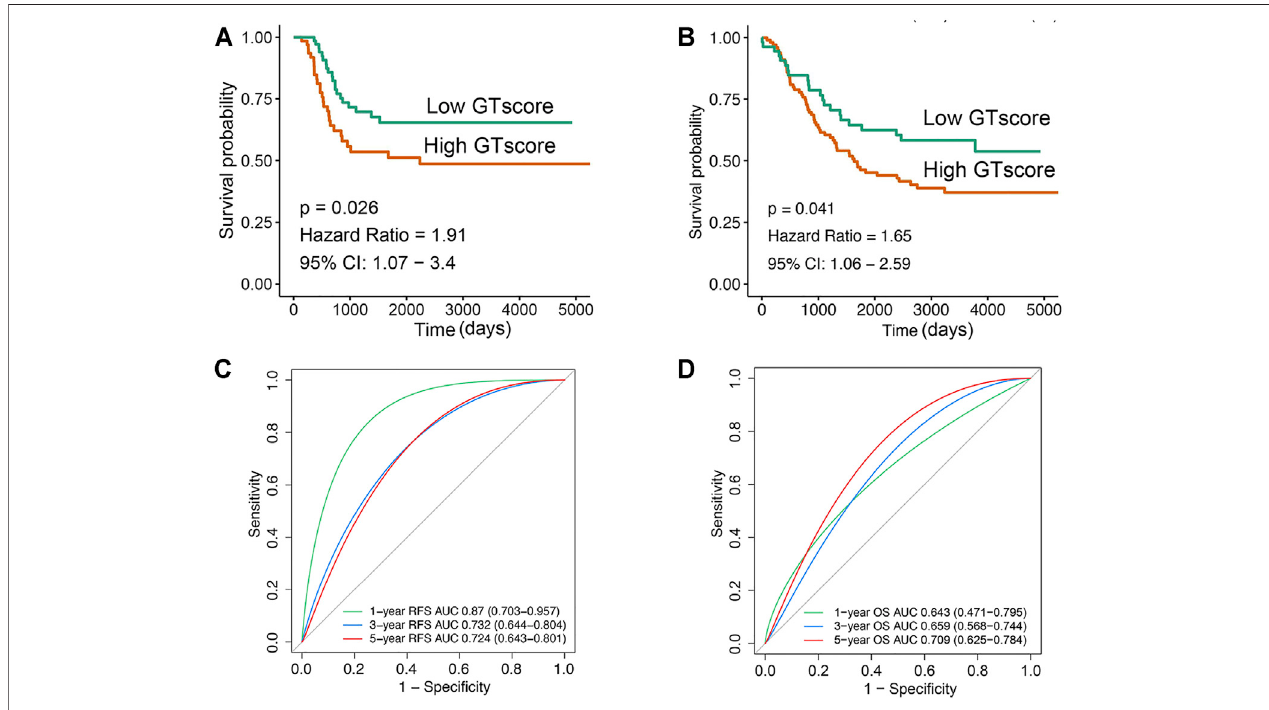
FIGURE 5 | Validation of the prognostic value of GTscore for NB patients in the validation set. Kaplan – Meier analysis for RFS (A) and OS (B) of NB patients. ROC analysis for 1-, 3-, and 5-year RFS (C) and OS (D) prediction in NB patients. The AUCs at 1, 3, and 5 years were calculated to assess the predictive accuracy.